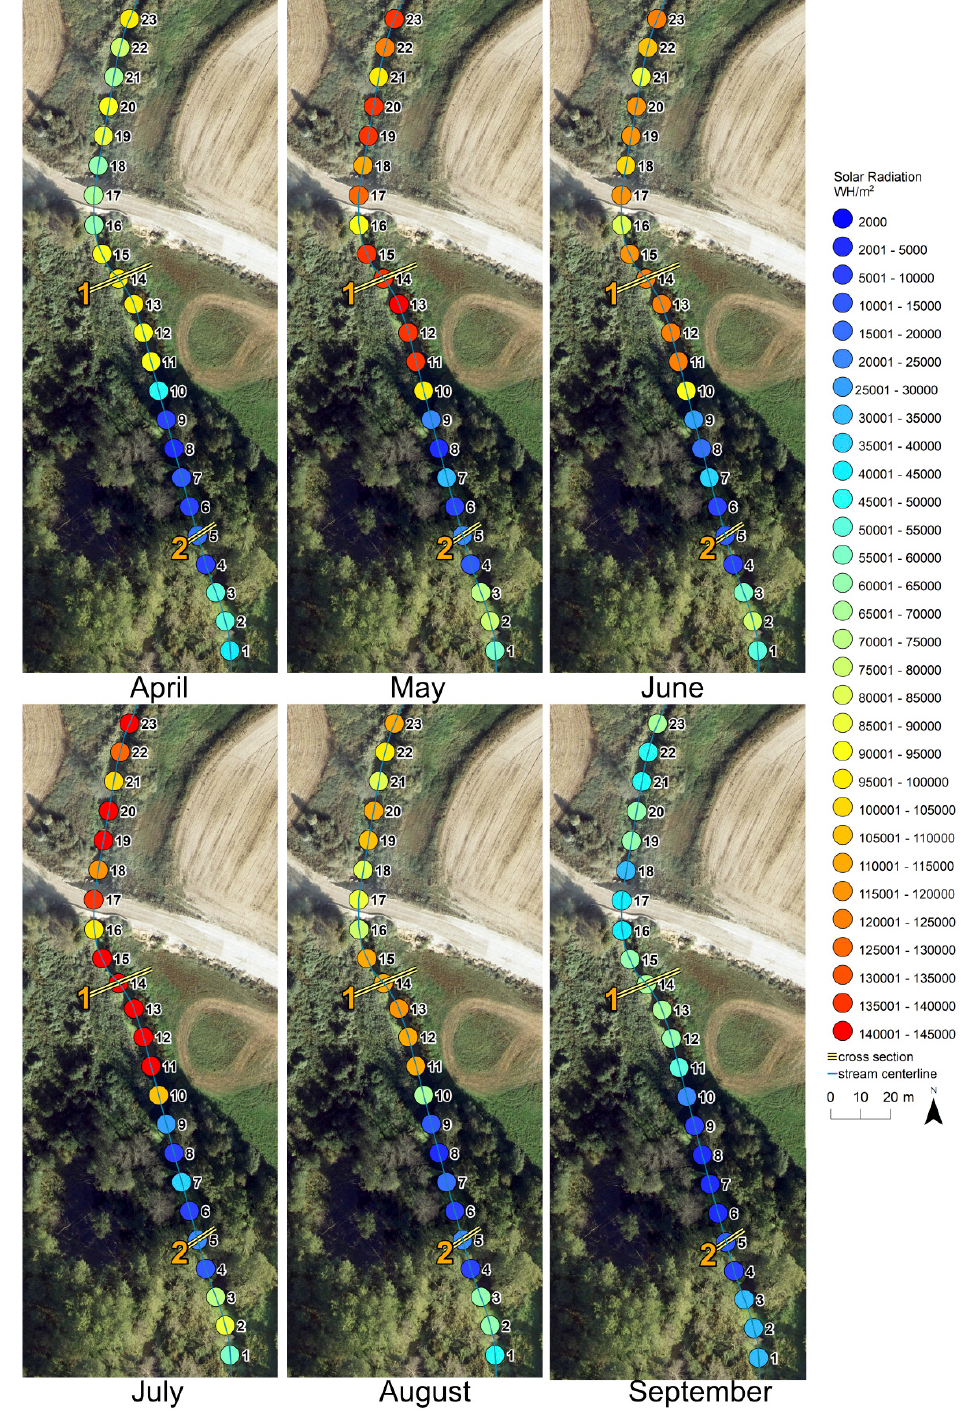
Figure 5. Distribution of total solar radiation (WH·m − 2 ) reaching the substrate in the analyzed Wełna River reach in individual months.